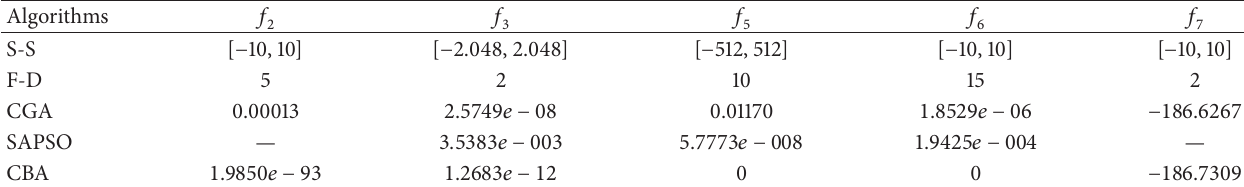
Table 2: Experimental results comparison between CGA, CBA, and SAPSO.